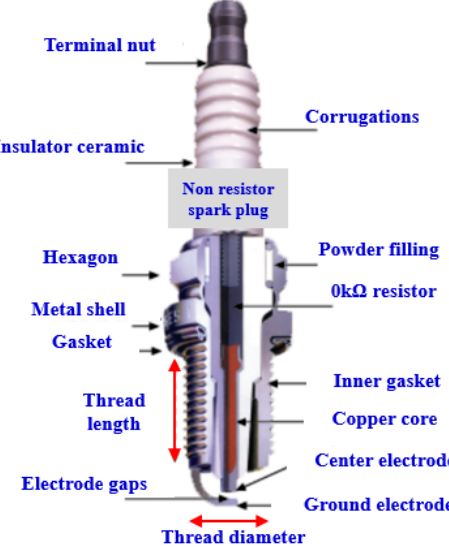
Figure 1. Composition of the non-resistor spark plug.